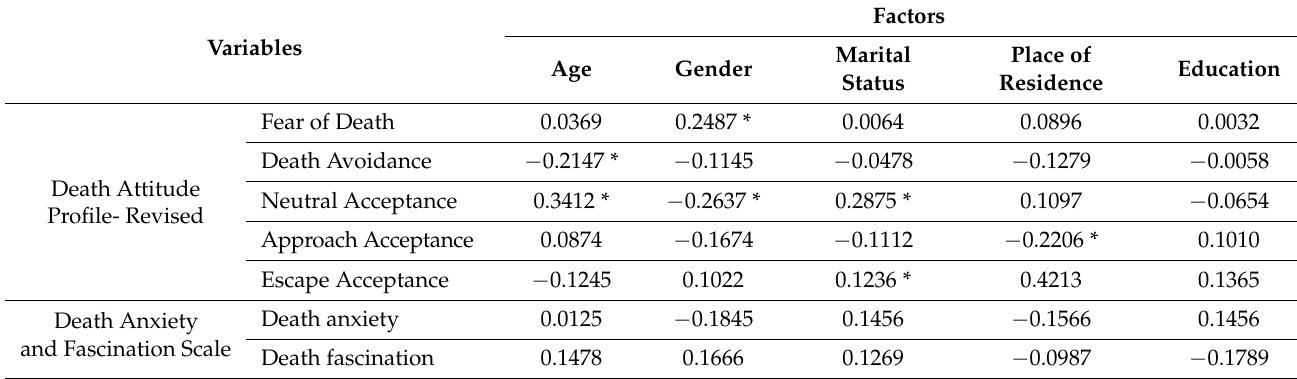
Table 5. Influence of respondents’ sociodemographic factors on attitudes toward death.